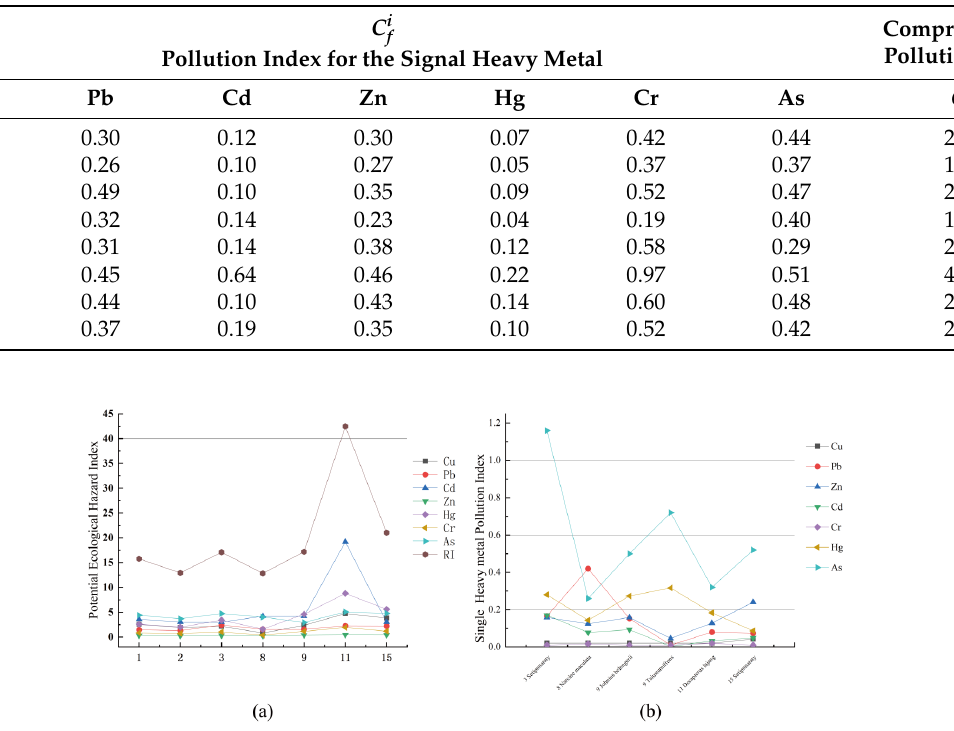
Table 6. Heavy metal pollution index in surface sediments.